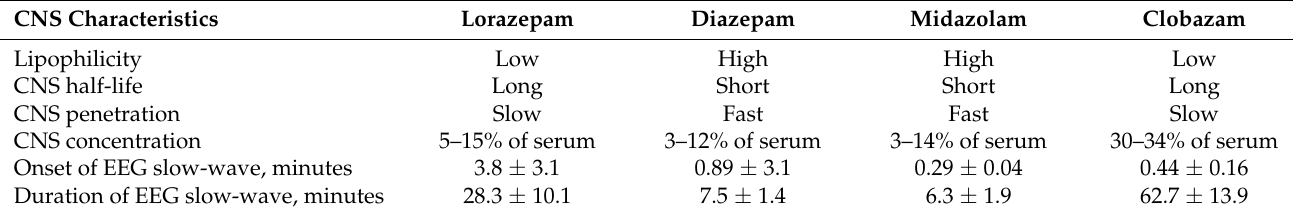
Table 3. Central nervous system pharmacokinetic characteristics of benzodiazepines